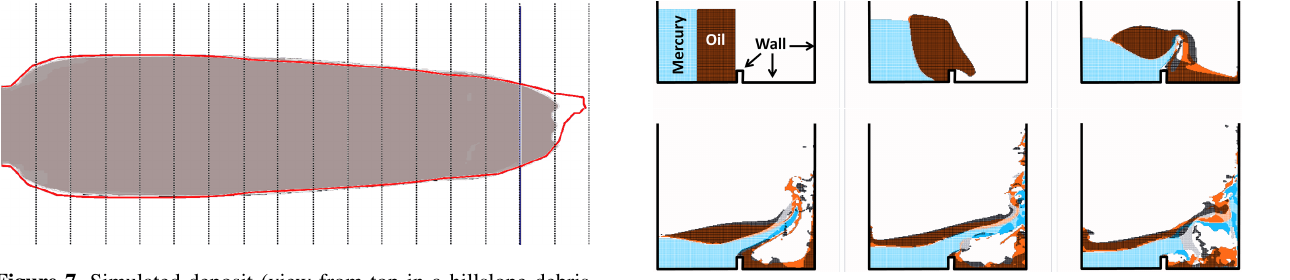
Figure 8. Phase positions in a dam break standard test-case simula- tion using a drag-based three-phase multiphaseEulerFoam simula- tion (air is transparent) as background shapes with the correspond- ing phase positions of our model as wire frame in front (with white mercury and black oil). The visualized time steps correspond to 0, 0.1, 0.2, 0.3, 0.4, and